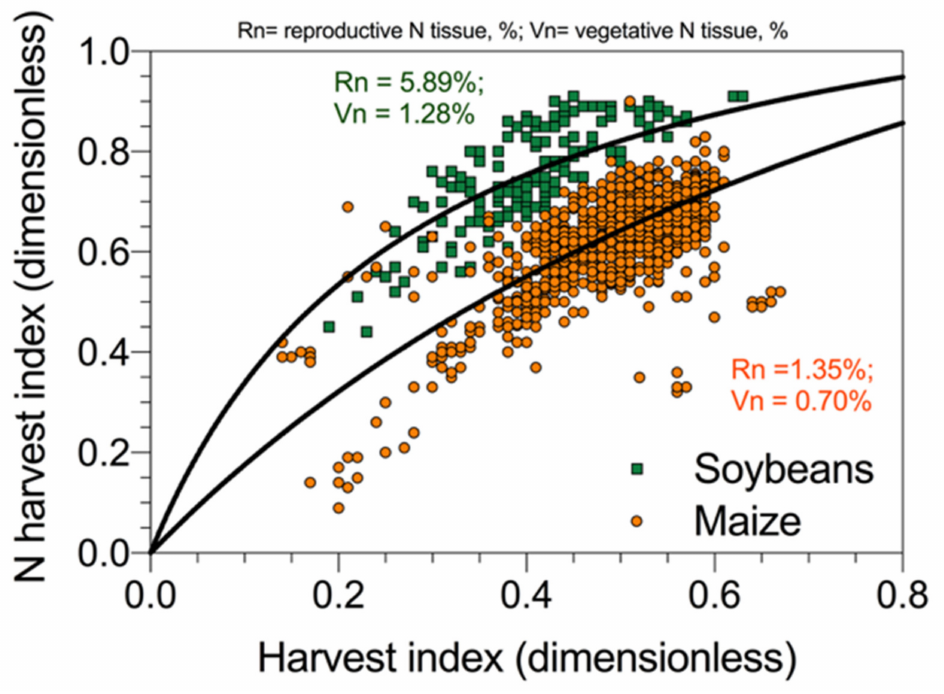
Figure 7. Relationship between nitrogen harvest index and dry mass harvest index for two crops, soybeans and maize, reporting the overall average N concentration for the reproductive (grain / seed) and vegetative (stover) plant fractions. Data redrawn from Ciampitti and Vyn (maize) [49] and from Tamagno et al. (soybeans)